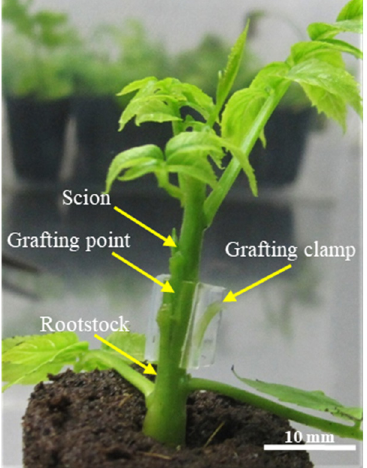
Figure 1. ‘Chandler’ graft over ‘Vlach’. The scion, rootstock, grafting point, and plastic clamp used for grafting maintenance are highlighted (arrows).